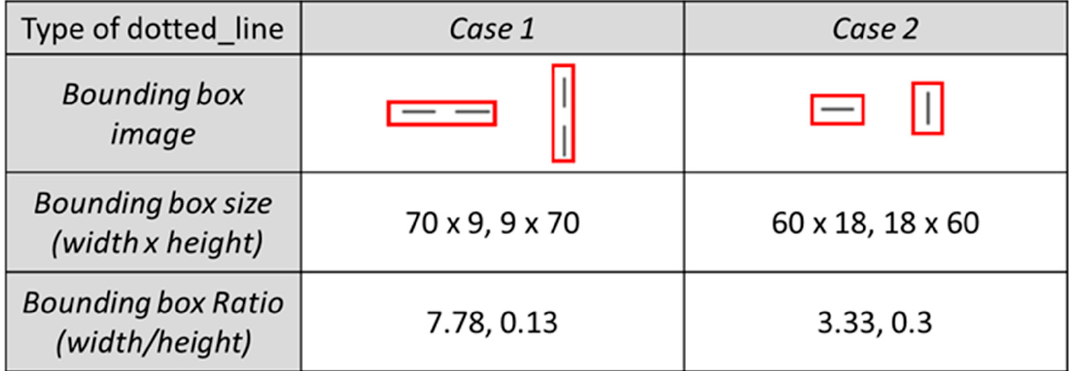
Figure 7. Change of bounding box set for the dotted line.